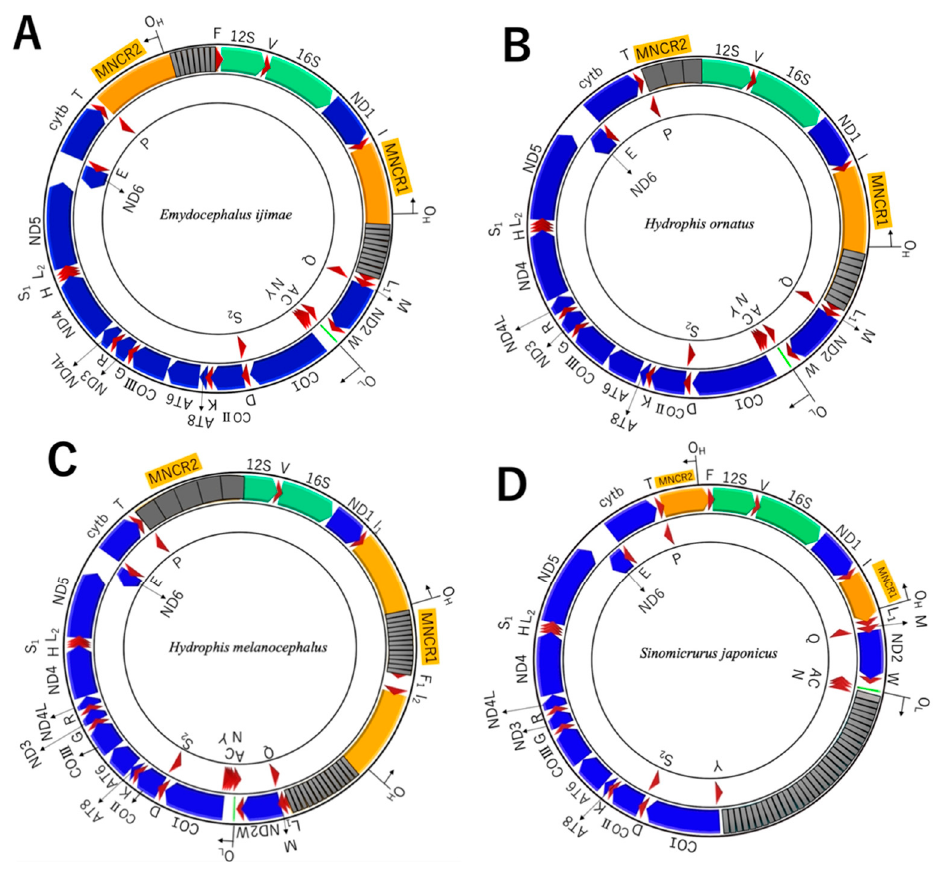
Figure 2. Gene arrangements of mitochondrial genomes of the four snake species sequenced in this study. ( A ): Emydocephalus ijimae , ( B ): Hydrophis ornatus , ( C ): Hydrophis melanocephalus and ( D ): Sinomicrurus japonicus . For abbreviations of genes and noncoding features, see the legend of Figure 1. Tandem gray boxes stand for tandem repeats with the indicated number of repeating times.